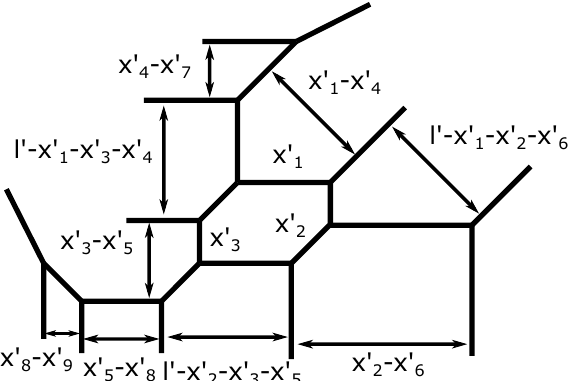
Figure 57. The web diagram of dP 9 which corresponds to the E-string whose compact surface is contained in the upper-right diagram in figure 55. The notation for the curve classes is the same as the one in figure 56. The curve classes here are represented with a prime